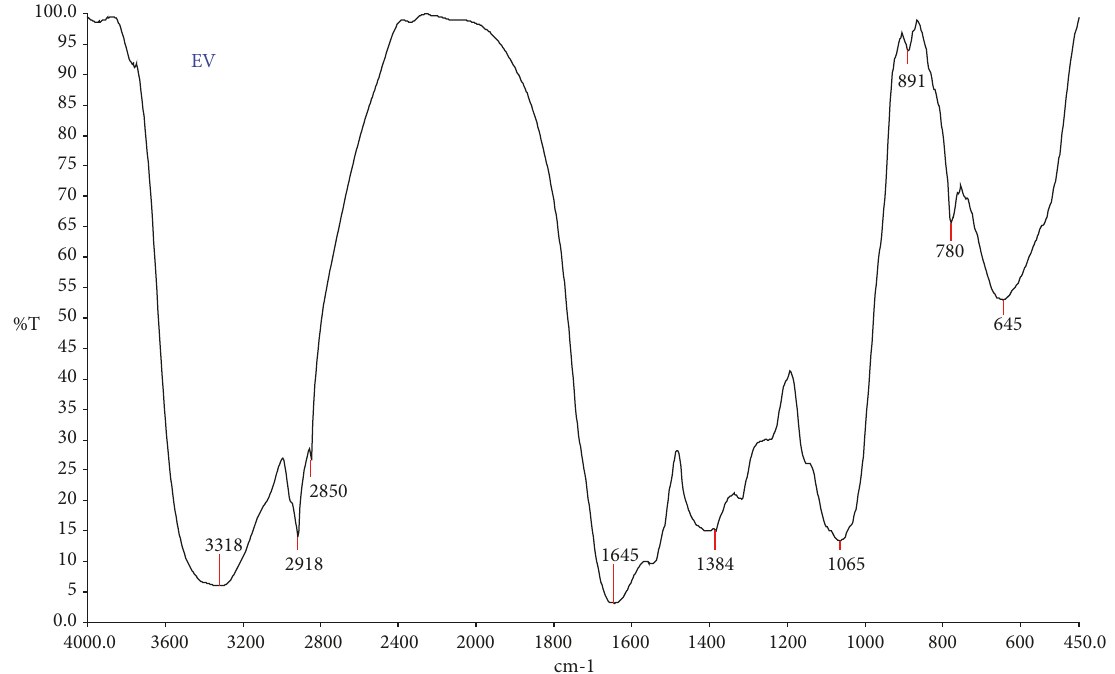
Values represent mean of five replications; mortality of the after 24 h of exposure period; LC 50 = lethal concentration brings out 50 % mortality; LC 99 = lethal concentration brings out 99 % mortality; different letters (a, b, c, and d) within the same row; R 2 = regression; 𝜒 2 = chi-squire; df a = degree of freedom; b significant at p < 0.05.